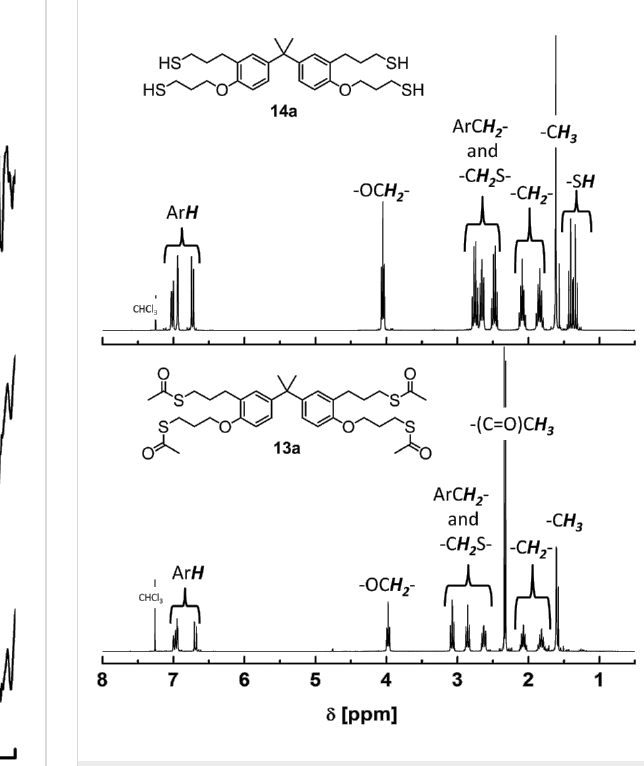
Figure 2: Top: 1 H NMR spectrum of 3,3’-(propane-2,2-diylbis(2-(3- mercaptopropoxy)-5,1-phenylene))bis(propane-1-thiol) ( 14a ) in CDCl 3 (300 MHz, rt); bottom: 1 H NMR spectrum of S , S ’-((propane-2,2- diylbis(2-(3-(acetylthio)propoxy)-5,1-phenylene))bis(propane-3,1-diyl)) diethanethioate ( 13a ) in CDCl 3 (300 MHz,